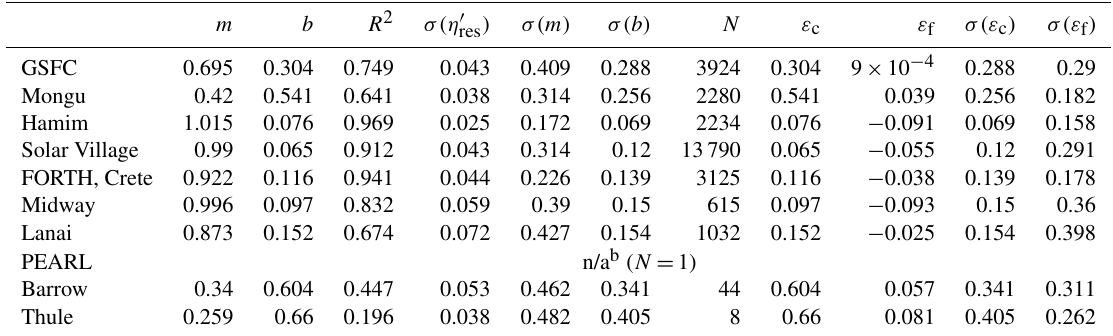
The Fig. 8 FO distributions of η (cid:48) − η vs. τ a more readily show the decreasing dispersion and the convergence towards = τ the η (cid:48) = η ( τ (cid:48) f ) line with increasing τ a (increasing τ f f